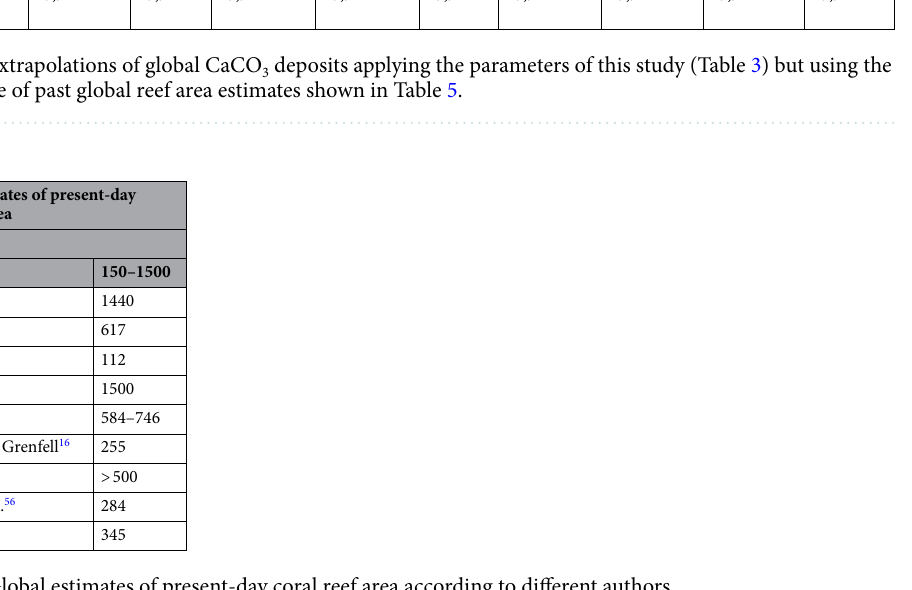
Table 5. Global estimates of present-day coral reef area according to different